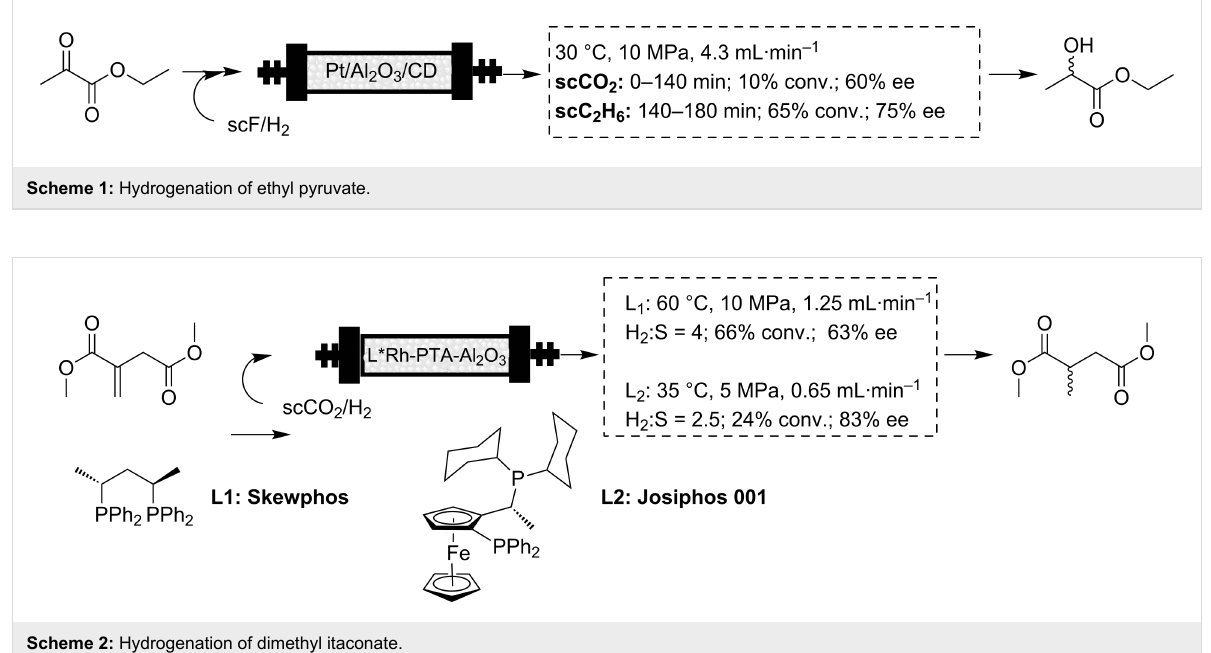
Scheme 2: Hydrogenation of dimethyl